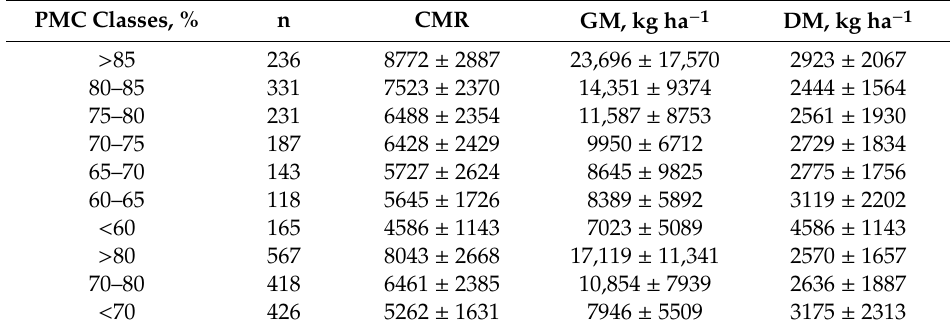
Table 2. Mean ± standard deviation of the parameters measured in the pastures of the three fields used in the calibration phase.